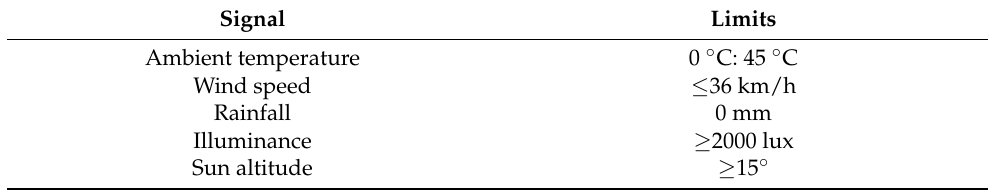
Table 4. Regulation limits for analyzed signals according to UNECE R152 CPNC.